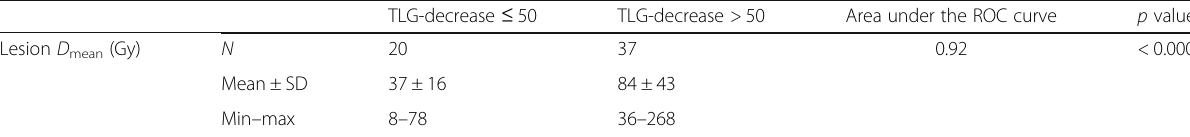
Table 4 Results of the univariate analysis for predicting a TLG-decrease of more than